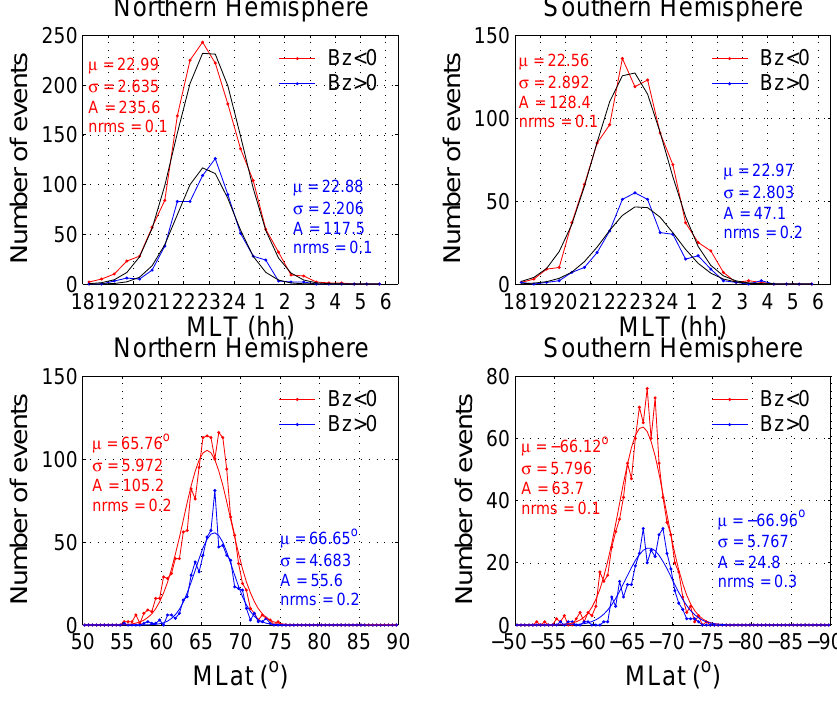
Fig. 4. Same as Fig. 3, but for IMF B z > 0 and B z < 0.